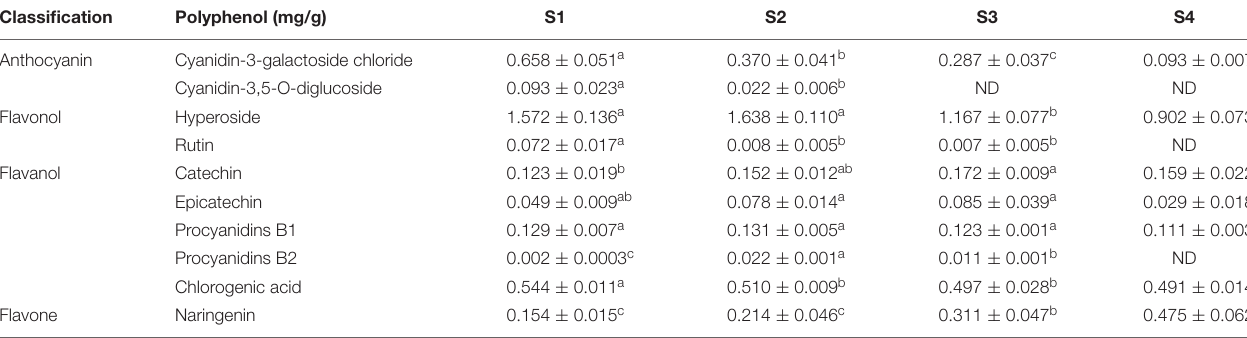
TABLE 1 | The HPLC results of leaf extraction of Malus ‘Radiant.’ Classification Polyphenol (mg/g) S1